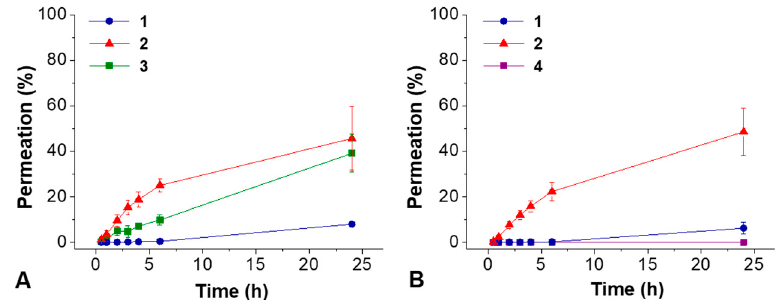
Figure 7. ( A ) hydrogel F , ( B ) hydrogel G . Percentages of Boc ‐ L ‐ Dopa(Bn) 2 OH ( 1 ) , Boc ‐ L ‐ Ala ‐ Aib ‐ L ‐ Val ‐ OH ( 2 ) , Trifluoroacetyl tripeptide ‐ 2 ( 3 ), Palmitoyl tripeptide ‐ 5 ( 4 ) permeated in 24 h, analyzed with HPLC ‐ MS. These percentages represent the quantity of compounds passing below the skin layer.